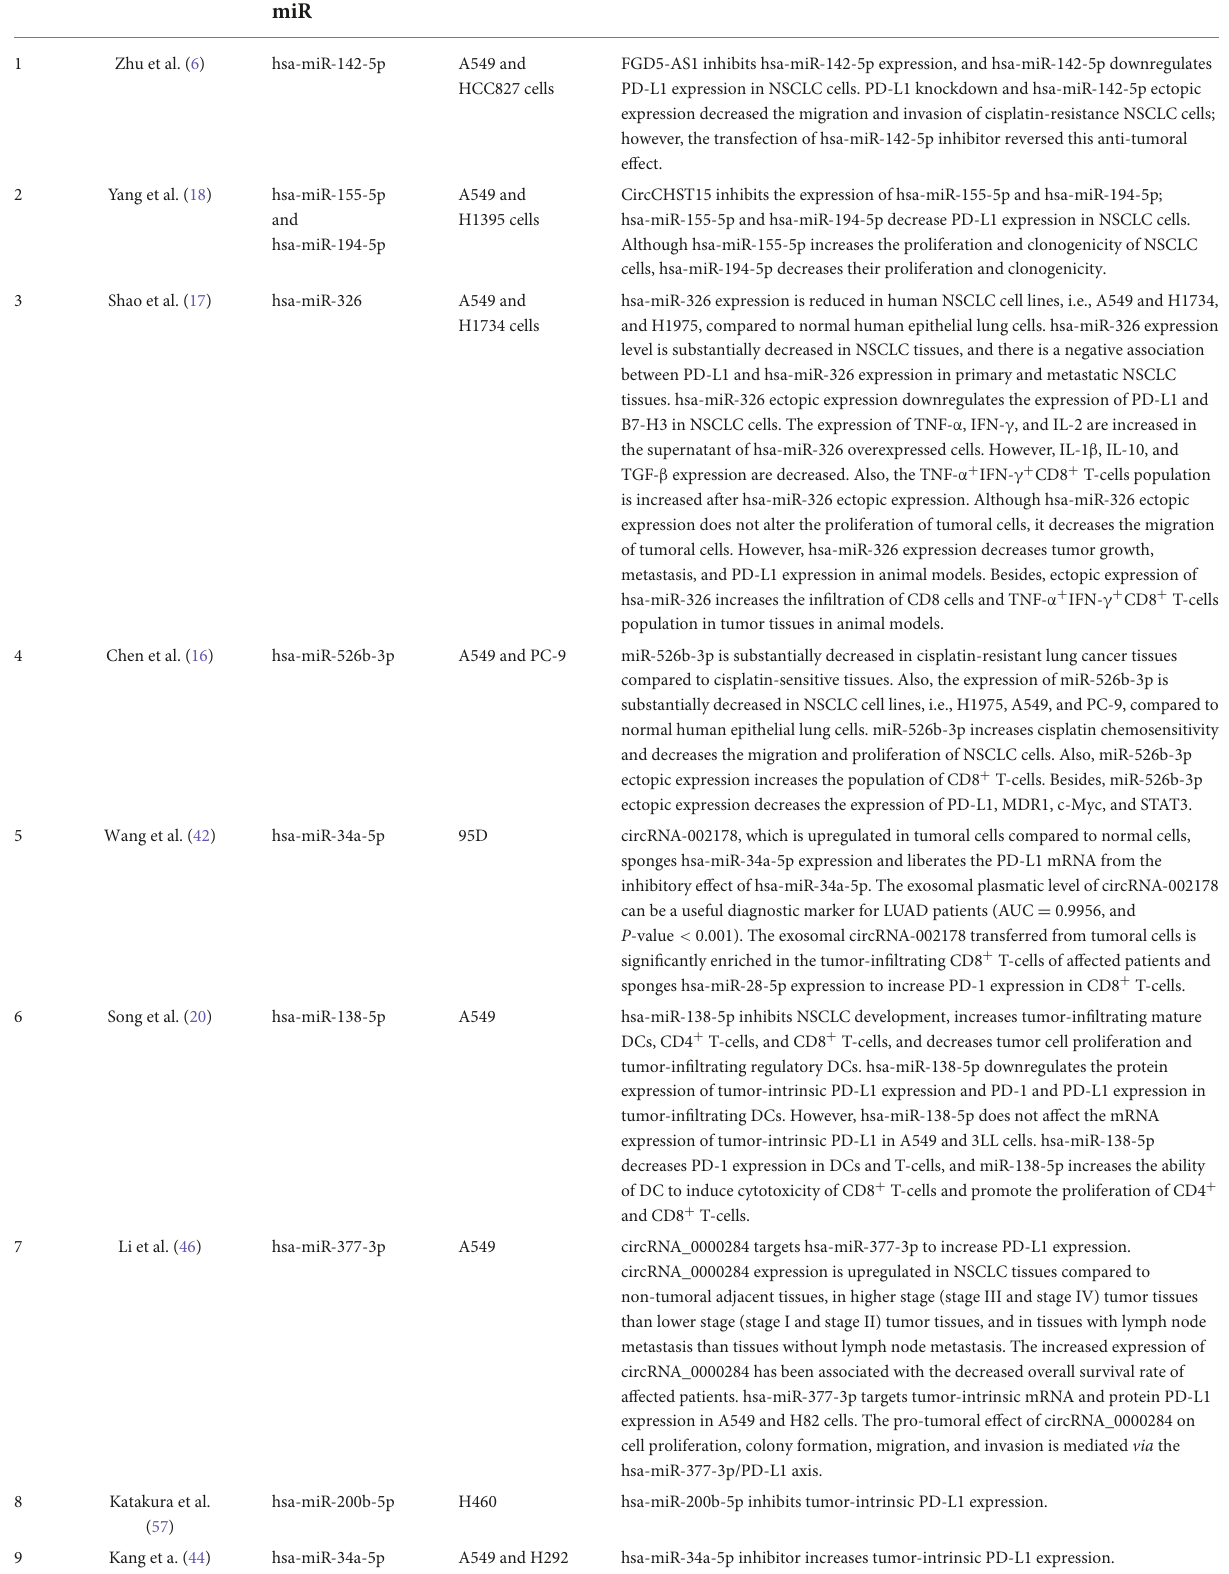
TABLE 2 The characteristics of the included